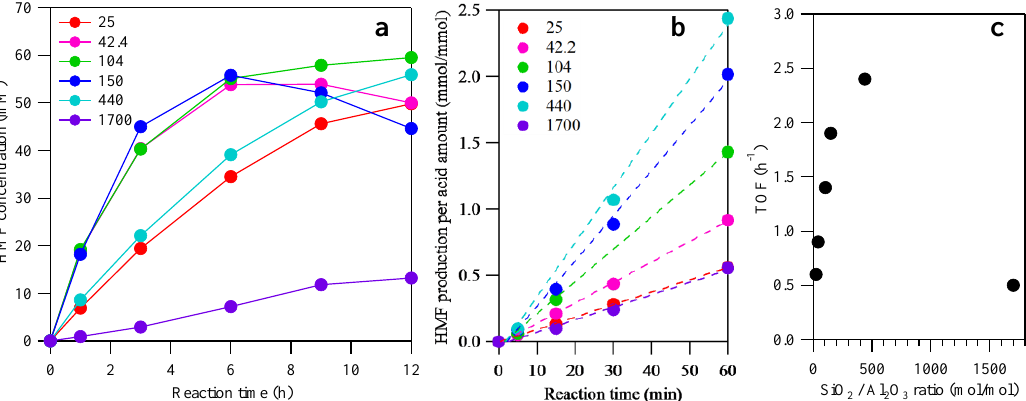
Figure 6. Time-based reaction progression of the hydroxymethylation of furfural to HMF among zeolite beta samples composed of different SiO 2 /Al 2 O 3 ratios in a batch reactor: ( a ) HMF concentration and ( b ) initial rate for HMF production per acid amount. ( c ) Plot of turnover frequency (TOF) values as a function of SiO 2 /Al 2 O 3 ratio on the basis of the dashed lines in (b) which represent the linear approximation results. Reaction conditions: furfural (1 mmol), formalin (5 mL), catalyst (200 mg), temperature (363 K), stirring (500 rpm).